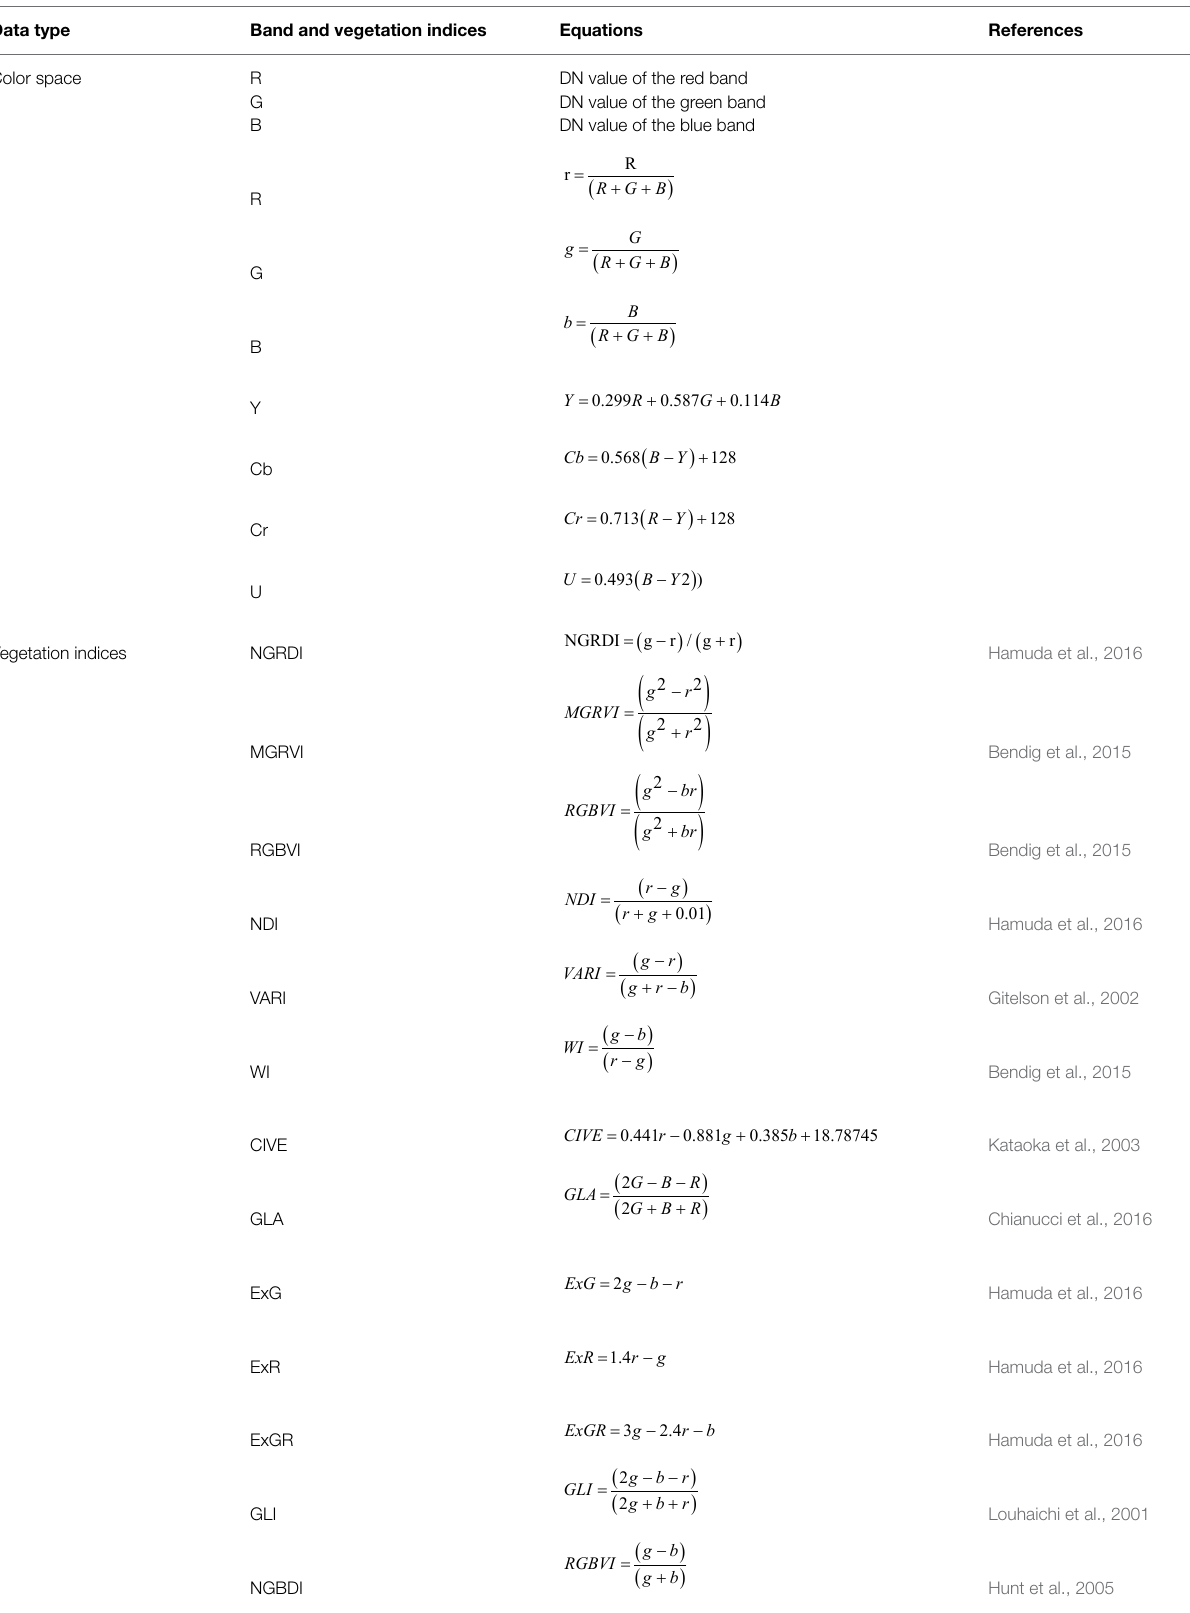
TABLE 1 | Review of the color space and vegetation indices used in this